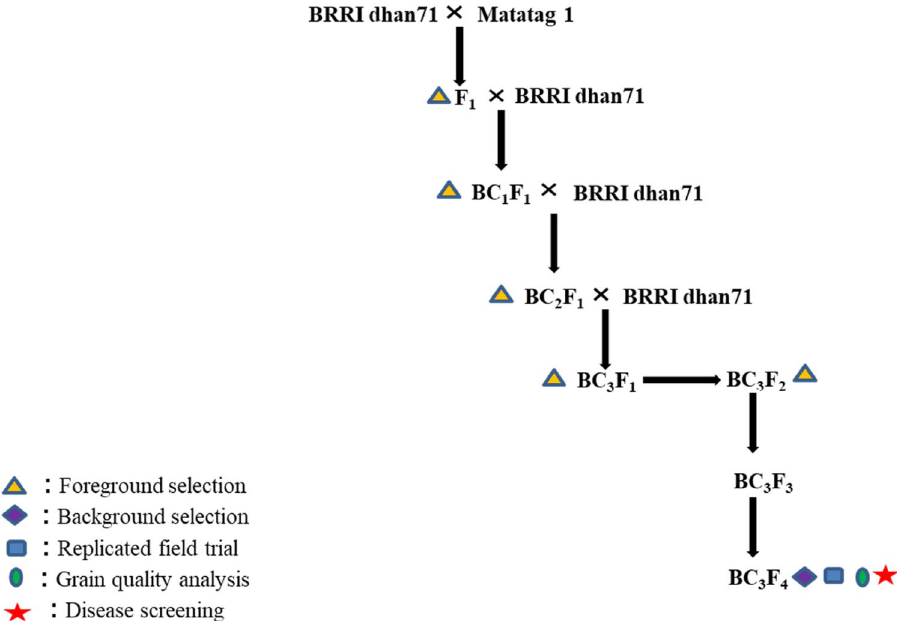
Figure 7. Breeding scheme for developing tungro resistant BRRI dhan71